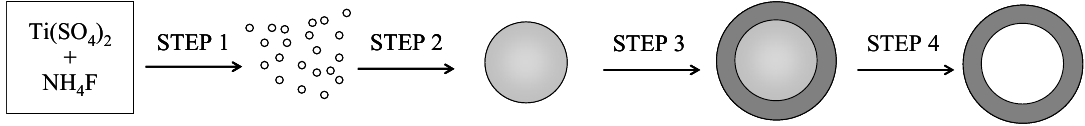
Figure 8. Schematic illustration of the formation of hollow TiO fluoride-mediated self-transformation